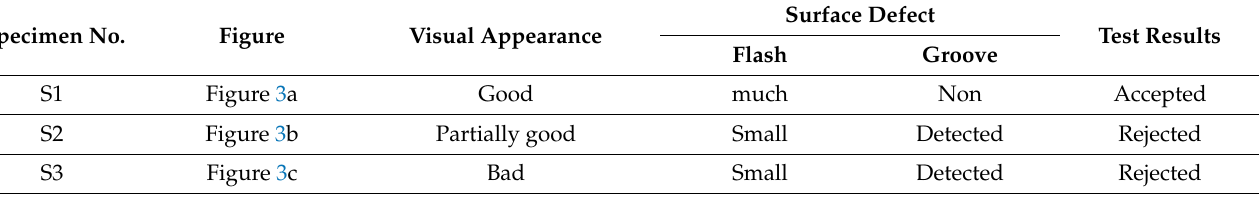
Table 4. Visual Inspections for the FSWed 2205 DSS Butt Welds.